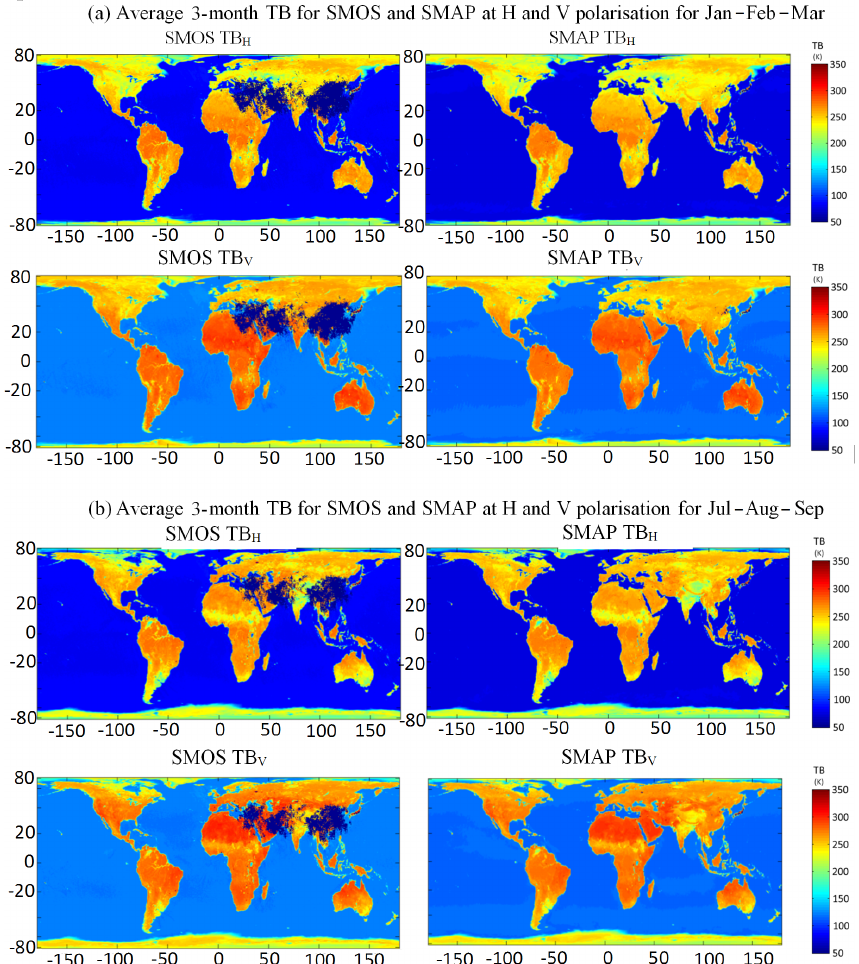
Figure 5. The 3-month average maps of SMOS L3 TB at 40 ◦ (left panels) and SMAP L3 TB (right panels) for H polarisation and V polarisation considering January, February, and March (a) and July, August, and September (b) .